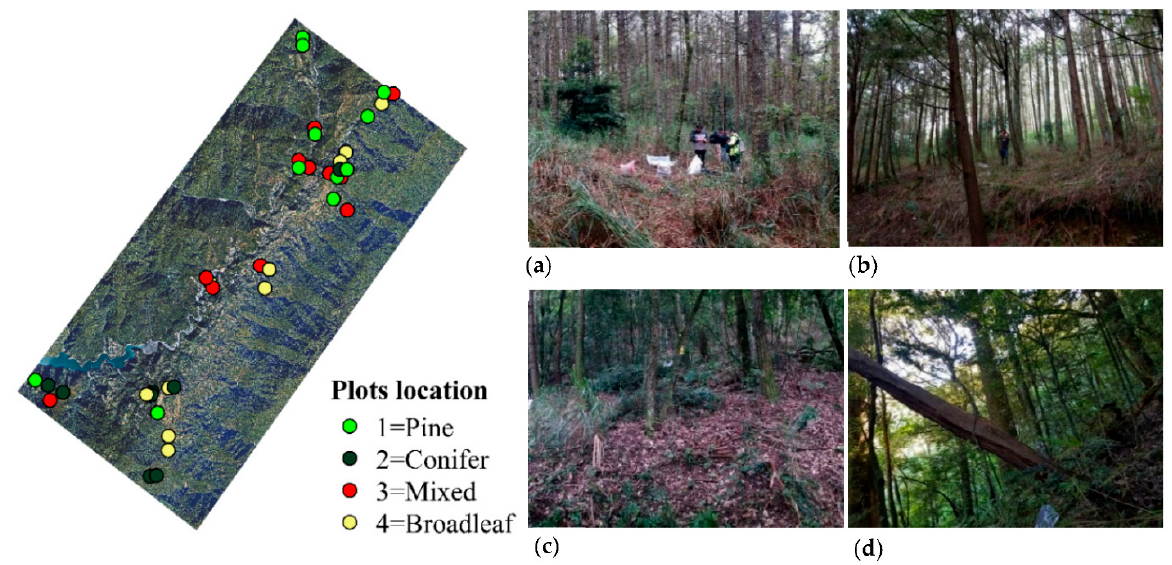
Figure 4. Location of plots for the fuel loading inventory. Subfigures ( a – d ) show the examples of the stands of pine, conifer, conifer-broadleaf mixed, and broadleaf forests.